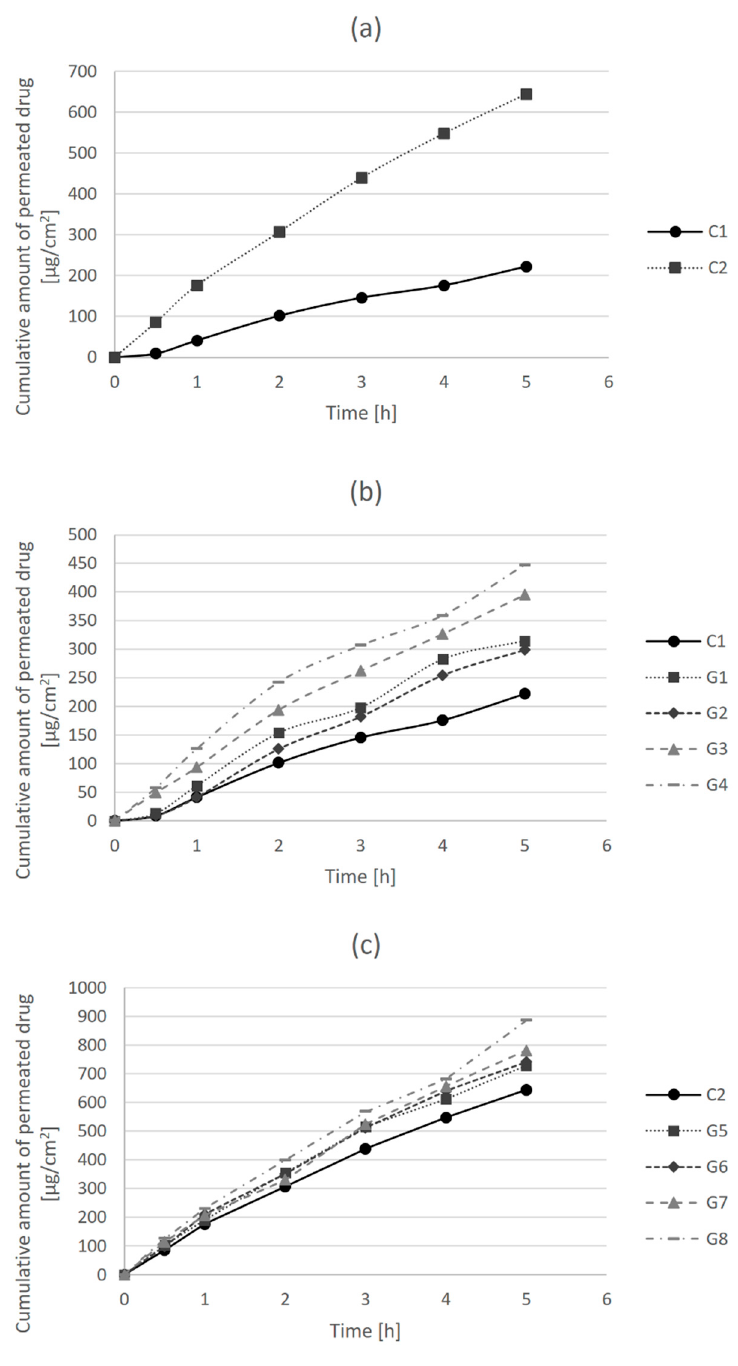
Figure 1. Dissolution profiles of clindamycin hydrochloride from hydrogel formulations: ( a ) control formulations C1 and C2; ( b ) hydrogels G1-G4 in comparison to control gel C1; and ( c ) hydrogels G5–G8 in comparison to control gel C2.